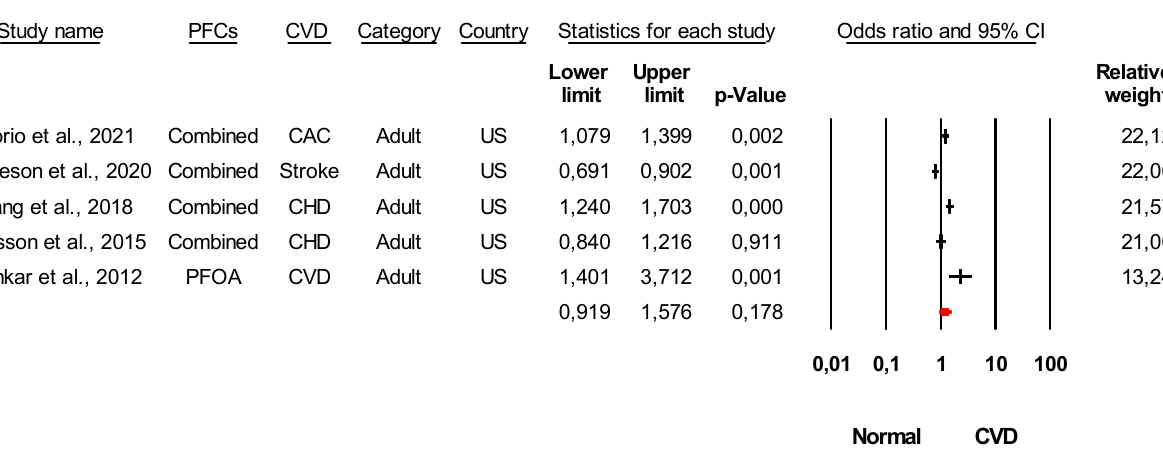
Figure 2. Association of PFCs exposure with CVDs. Meta-analysis using random-effects model, ordered by their date of publication. PFCs combined = combination of more than 2 PFCs. CAC = coronary artery calcium, CHD = coronary heart diseases, CVD = cardiovascular disease. Test for overall effect: z = 2.2, p = 0.02; Test for heterogeneity: I 2 = 91.6% Q = 77 df = 4, p <